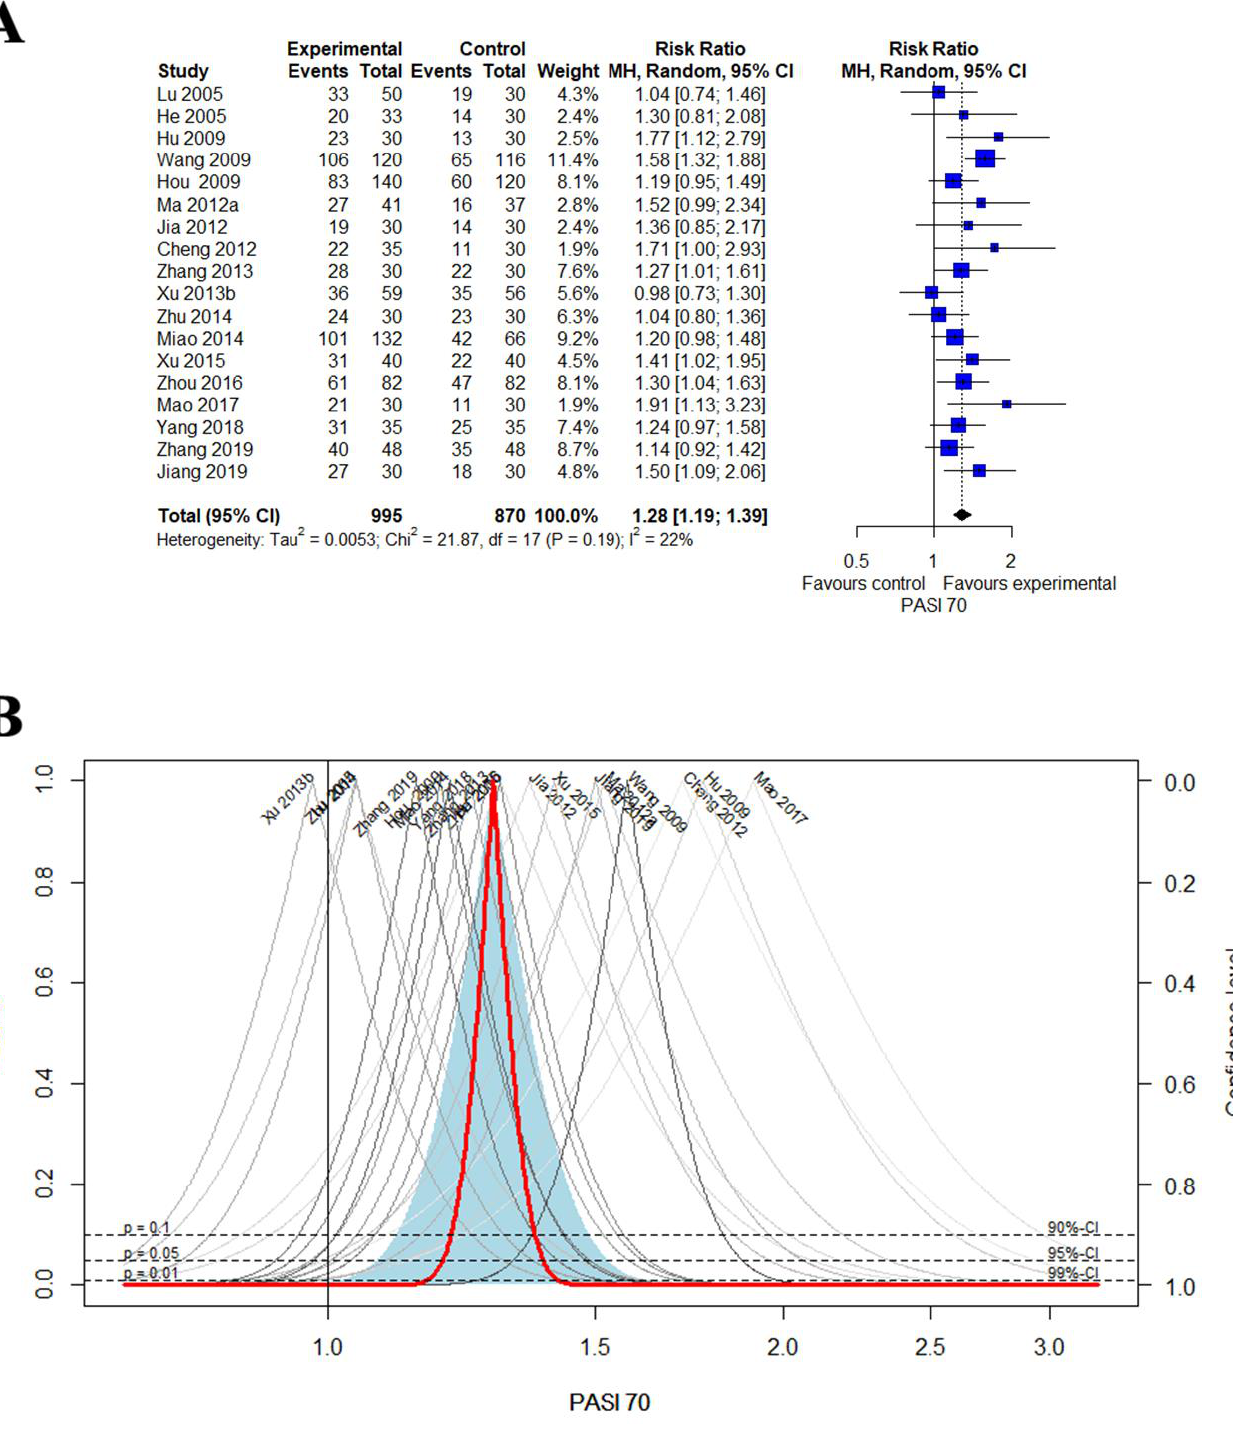
Figure 2. ( A ) Forest plot of the trials that compared EAHM with CM for PASI 70; ( B ) drapery plot of the trials that compared EAHM with CM for PASI 70.